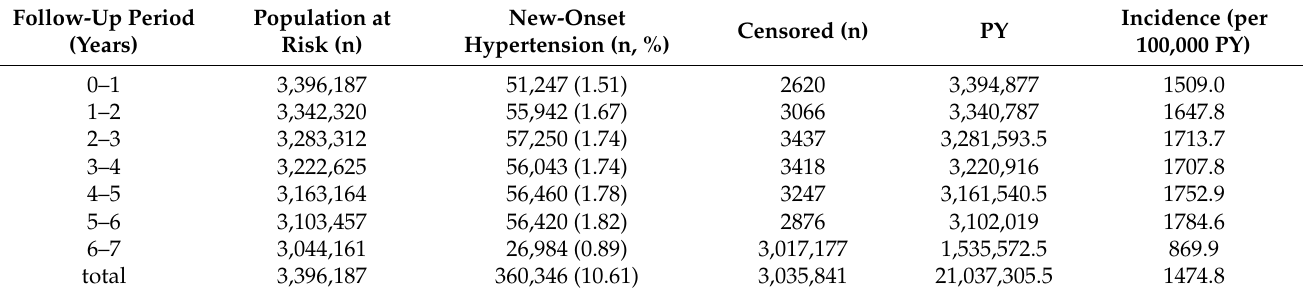
Table 3. Incidence density of new-onset hypertension by